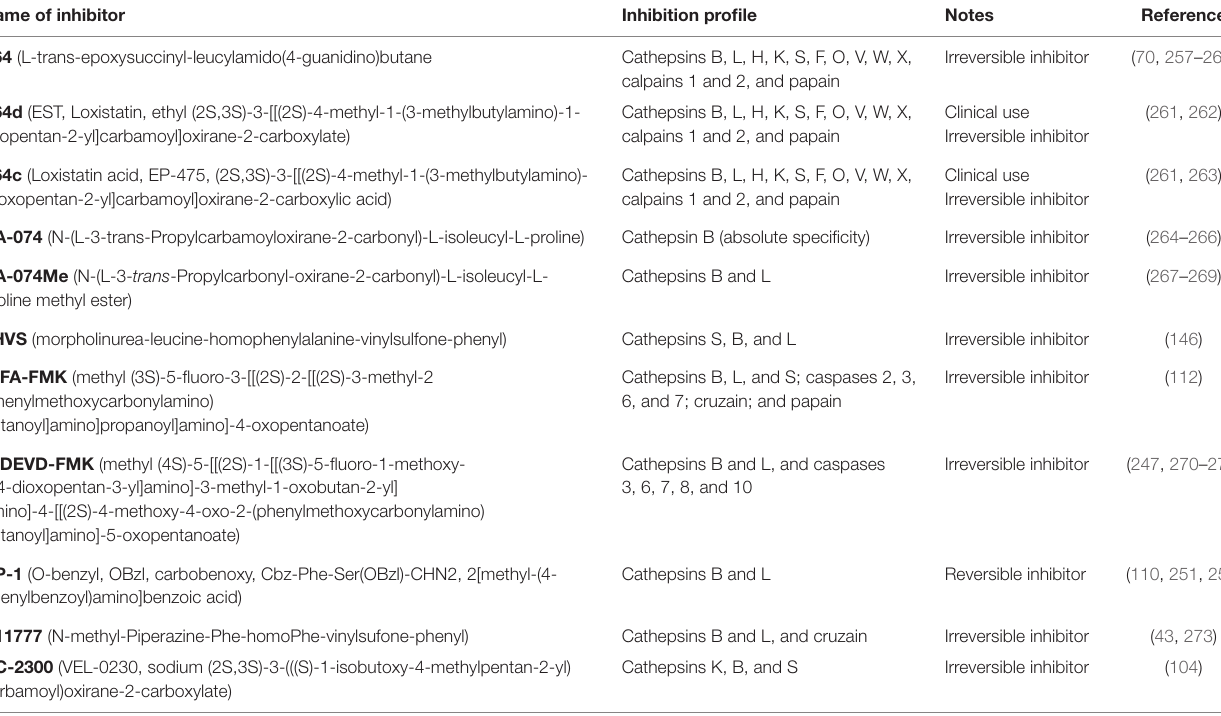
TABLe 7 | Protease inhibition profiles of small molecule inhibitors of cathepsin B, from studies of TBi and TBi-related animals. Name of